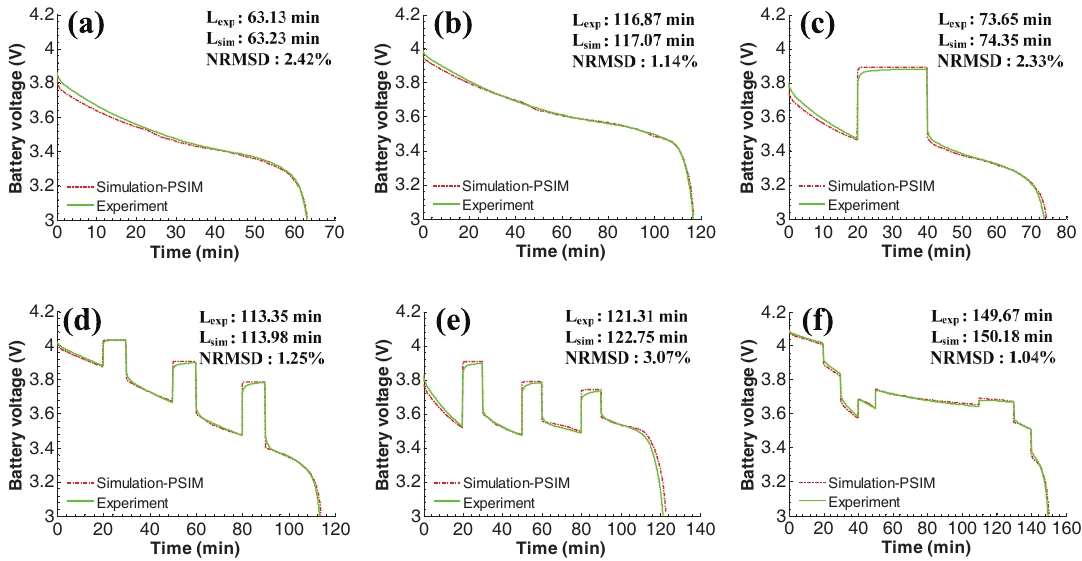
Figure 14. Model validation by PSIM simulations: ( a ) heavy load ( P 1 ); ( b ) light load ( P 2 ); ( c ) interrupted load ( P 3 ); ( d ) increasing load ( P 4 ); ( e ) decreasing load ( P 5 ); ( f ) varying load ( P 6 ). Table 3. Simulation result comparisons. NRMSD, normalized root mean square deviation. P 1